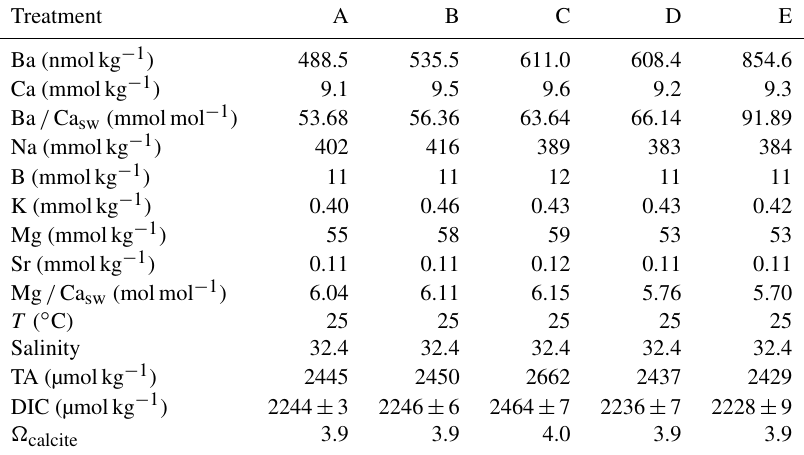
Table 1. Measured concentrations of major and minor ions, temperature, salinity, and carbonate chemistry in the five culture media (A–E).